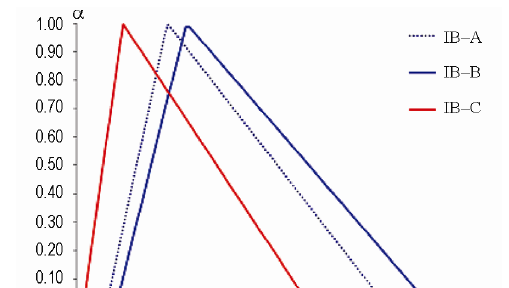
Table 6. The comparison results for intelligent